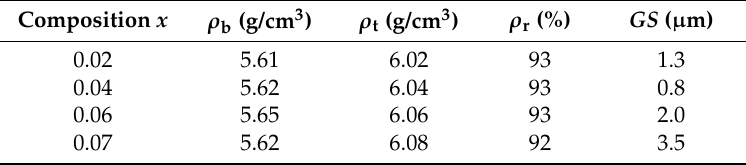
Table 1. Values of ρ b , ρ t , ρ r and average grain size ( GS ) for (Ba 1 − x Sm x )(Ti 0.99 Mn 0.01 )O 3 ceramics. Composition